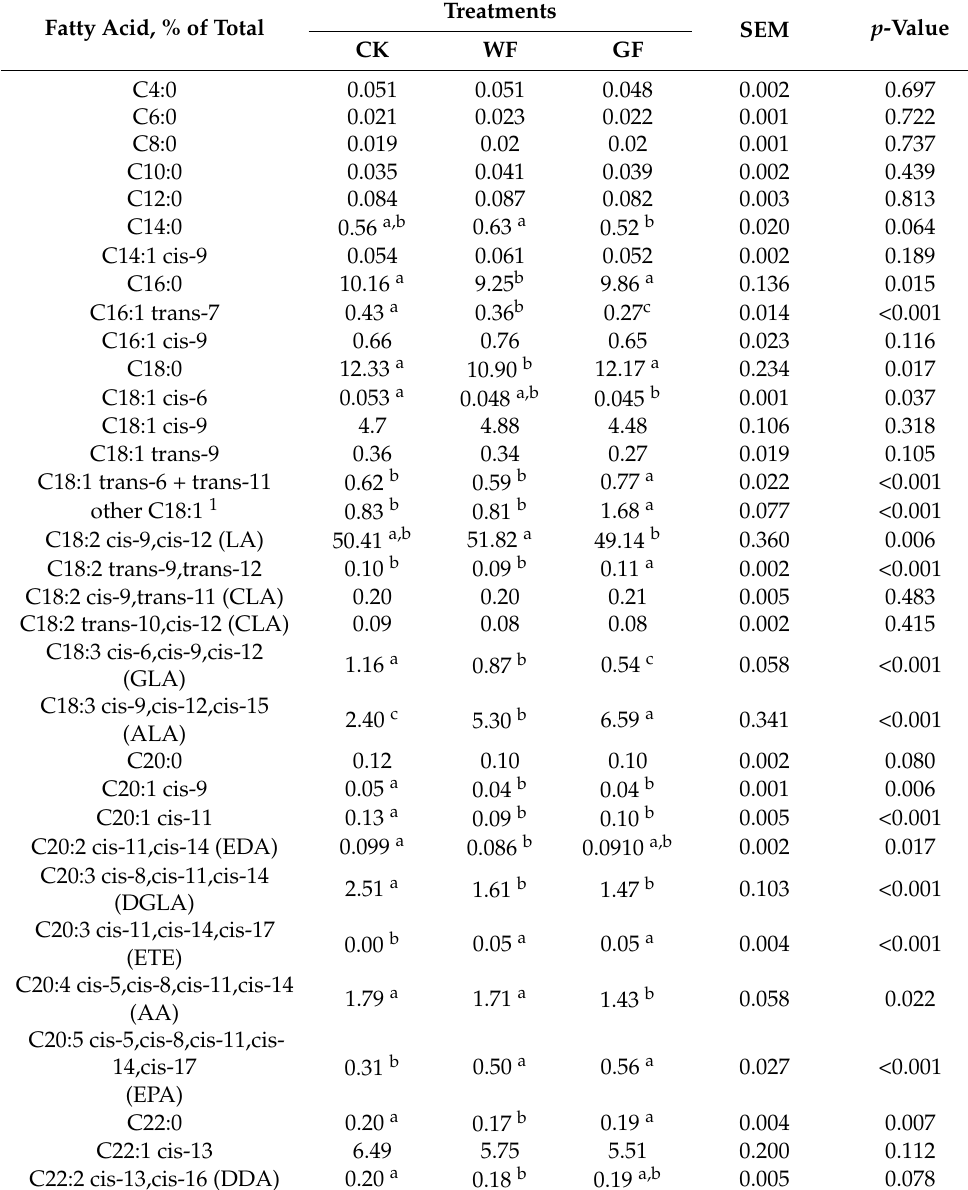
Table 3. Plasma fatty acid composition of cows in different treatment